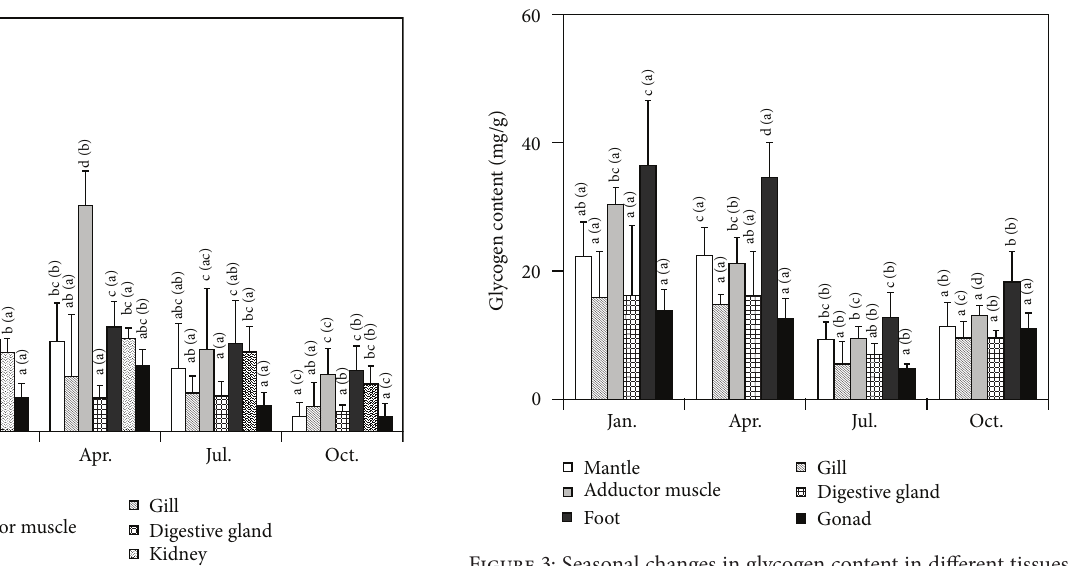
Figure 3: Seasonal changes in glycogen content in different tissues from ark shells, Scapharca kagoshimensis . Bars represent means and whiskers represent standard deviation. 4–6 samples (replicates) were used for the analysis of each organ. No common letters out of parentheses indicate significant differences of glycogen contents in different tissues on each month and no common letters in parentheses indicate significant differences of seasonal changes on each tissue ( 𝑃 < 0.05 ; Tukey-Kramer